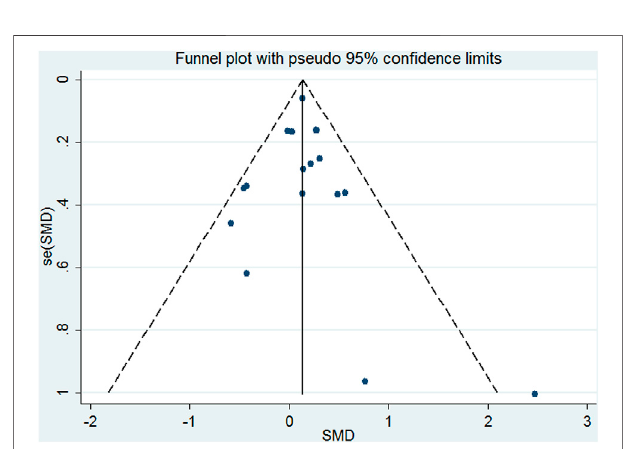
FIGURE 2 | Funnel plots illustrating the meta-analysis (change data) of the ef fi cacy of HPA-targeting treatments for depression.